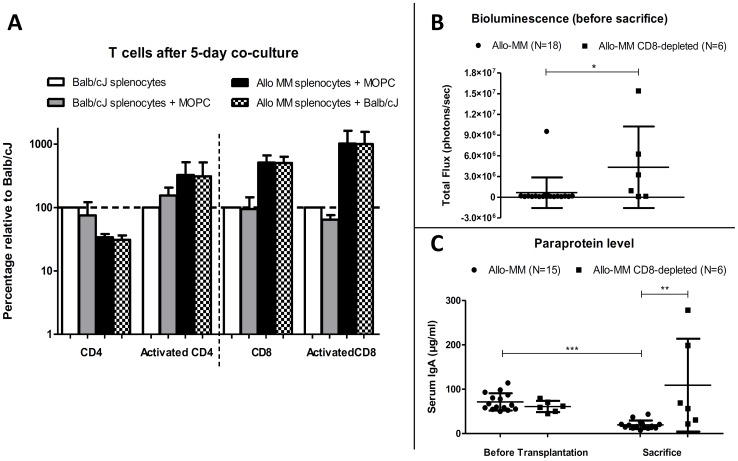
Involvement of CD8 T cells in the graft-versus-myeloma effect.(A) In vitro T-cell reactivity. Relative percentages (mean±SD), normalized to those of non-activated Balb/cJ splenocytes alone, are represented for 3 independent experiments of 5-day co-cultures of splenocytes (Balb/cJ alone; Balb/cJ + irradiated MOPC315.BM cells; Allo−MM + irradiated MOPC315.BM cells; or Allo−MM + irradiated Balb/cJ splenocytes). Activated cells displayed a CD69+ phenotype. In vivo implication of CD8 T cells (CD8 T-cell-depletion of the graft). (B) Bioluminescence quantitation. Total flux (photons/sec) measured on the dorsal side just before sacrifice (mean±SD), *p<0.05. (C) Paraprotein level. Serum IgA quantitation (µg/ml) by ELISA before transplantation and at sacrifice (mean±SD), **p<0.005; ***p<0.0001 (Mann-Whitney Test).